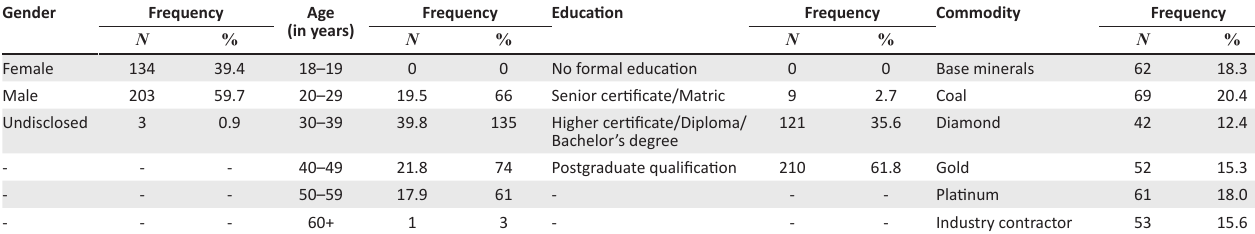
TABLE 1: Sample description.